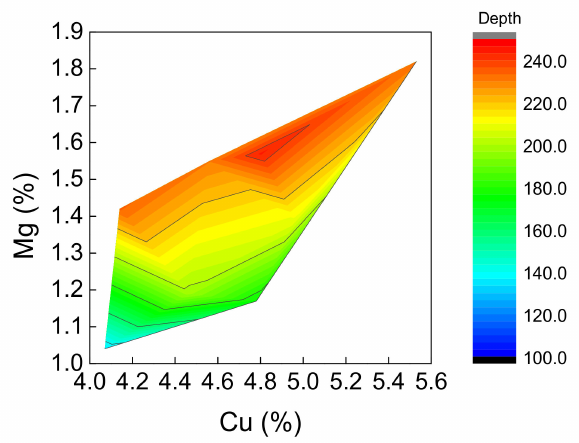
Figure 9. The effect of Cu and Mg on the average corrosion depth of 2024 alloy. Table 2. The maximum and average of corrosion depth for the different alloy samples with different quenching transfer